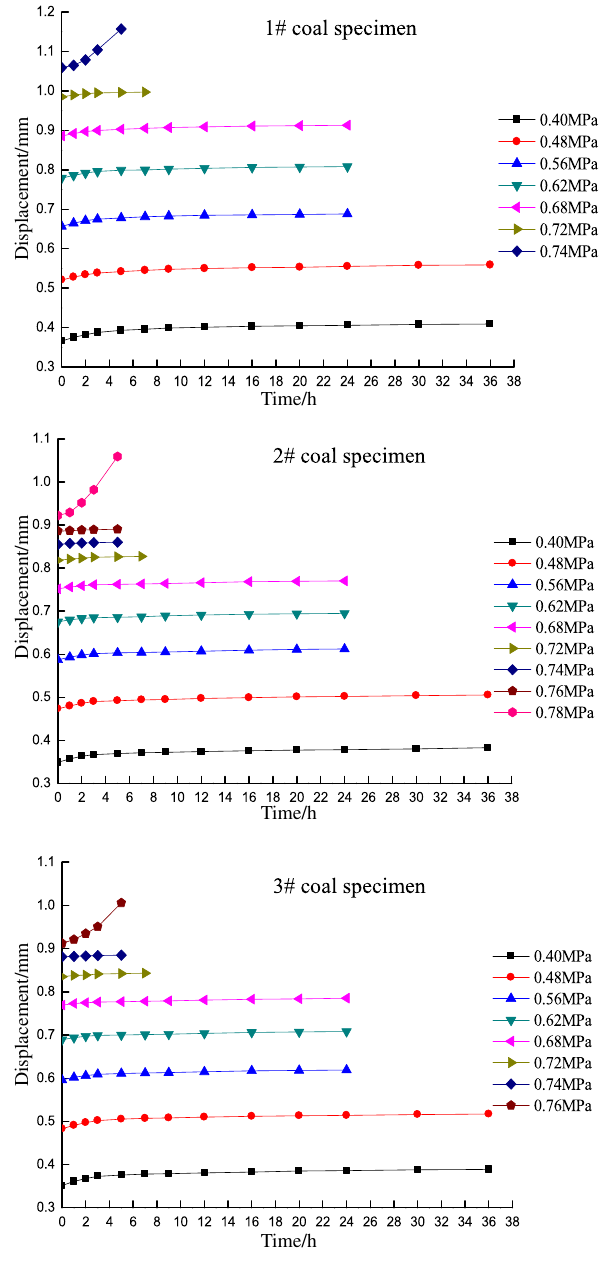
Figure 3. Strain–time curves of different shear stresses under various normal stress conditions for the 7-day